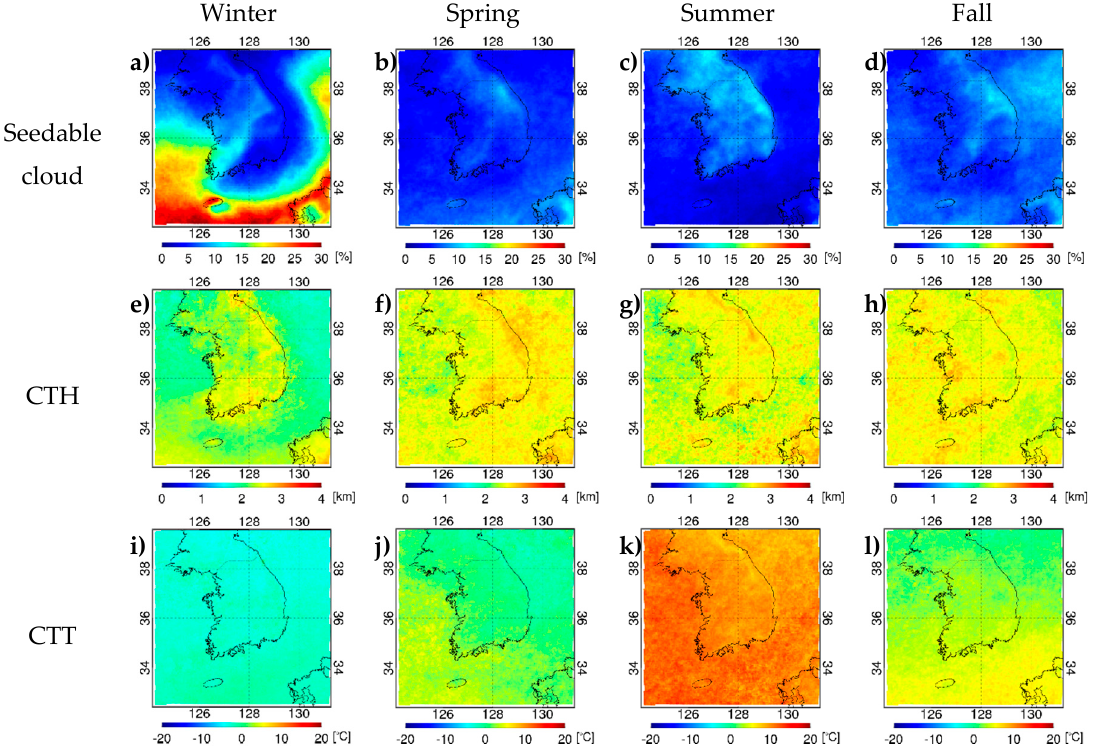
Figure 4. Frequency distribution of water phase seedable clouds ( a – d ) and cloud characteristics (CTH: ( e – h ), CTT: ( i – l )) around the Korean Peninsula.